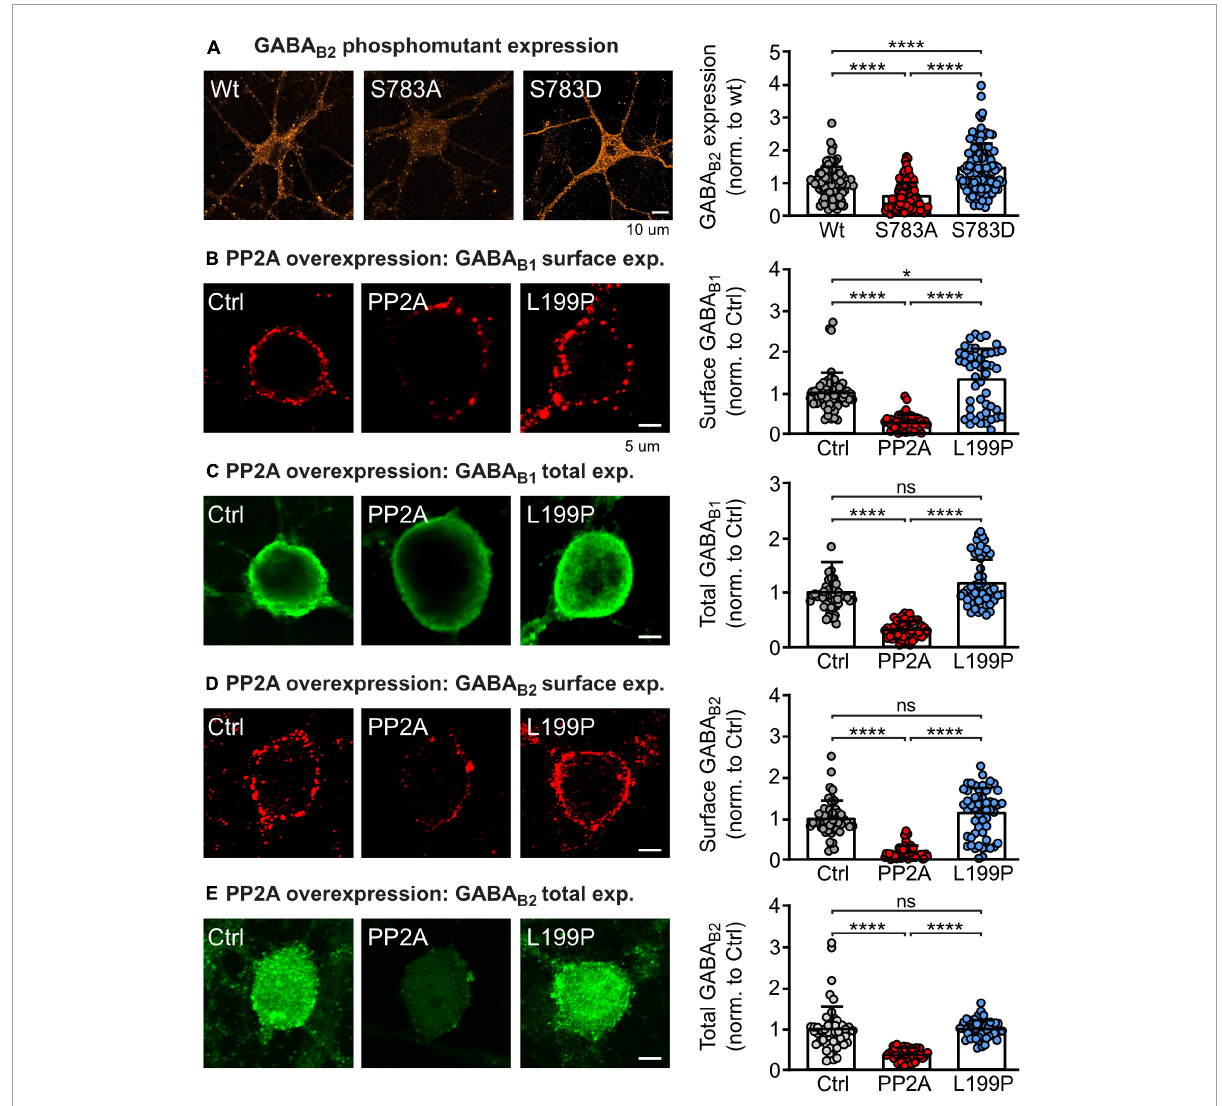
FIGURE1 PP2A regulates GABA B receptor expression. (A) Phosphorylation/dephosphorylation of GABA B2 (S783) affects expression of GABA B receptors. Neurons were transfected either with wild type HA-tagged GABA B2 , a HA-tagged GABA B2 mutant with inactivated S783 phosphorylation site 783 (S783A) or with a mutation mimicking phosphorylation of this site (S783D) along with wild type GABA B1 . Expression of HA-tagged GABA B receptors was determined after 2 days by staining with antibodies directed against the HA-tag. Left: Representative images of total GABA B receptor expression (scale bar: 10 µ m). Right: Quantification of GABA B2 staining. Expression levels were normalized to the control (wild type HA-GABA B2 ). The data represent the mean ± SD of 87–144 neurons from three independent. Brown–Forsythe and Welch ANOVA with Games Howell’s multiple comparison test (**** p < 0.0001). (B–E) Overexpression of the catalytic subunit of PP2A (PP2A-C) downregulates total and cell surface expression of GABA B receptors in neurons. Neurons were transfected with EGFP and either PP2A-C or an inactive mutant of PP2A-C (L199P). Cell surface and total endogenous GABA B1 (B,C) and endogenous GABA B2 (D,E ) was determined after 2 days via staining with GABA B1 and GABA B2 antibodies. Left: Representative images (scale bar: 5 µ m). Right: Quantification of GABA B receptor staining. Signals were normalized to the control (only transfected with EGFP). The data represent the mean ± SD of 87–144 neurons from three independent. Brown–Forsythe and Welch ANOVA with Games Howell’s multiple comparison test (ns, p > 0.05, * p < 0.05, **** p < 0.0001).